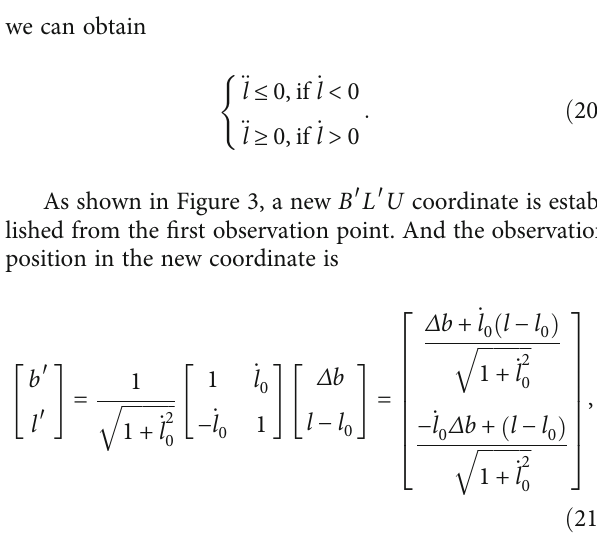
. (a) is the variation of ξ uq